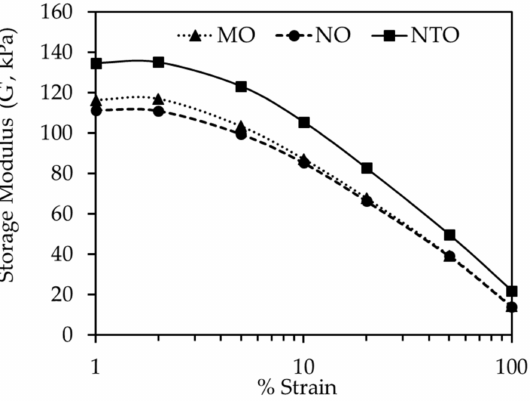
Figure 6. Storage modulus (G ´ ) of the rubber compounds as a function of strain at 6 phr of different oils.